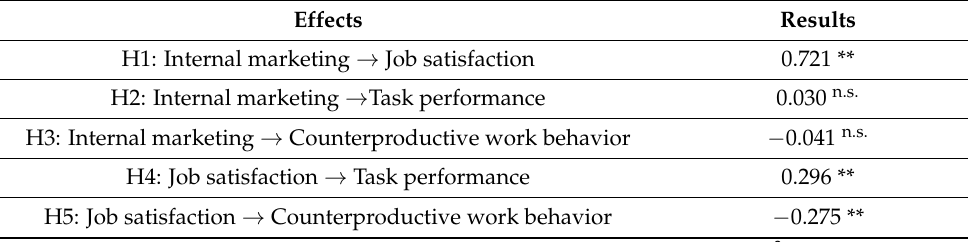
Table 4. The influence of internal marketing on job satisfaction and job